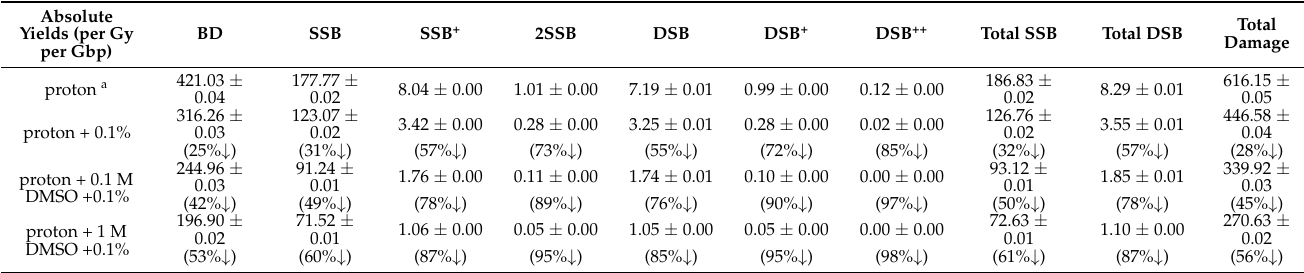
Table 4. Absolute Yields of DSB Inductions for Cells Irradiated with Proton Ions (LET = 1.051 keV/ µ m) under 0.1% Oxygen (O 2 ) and at Various Concentrations of